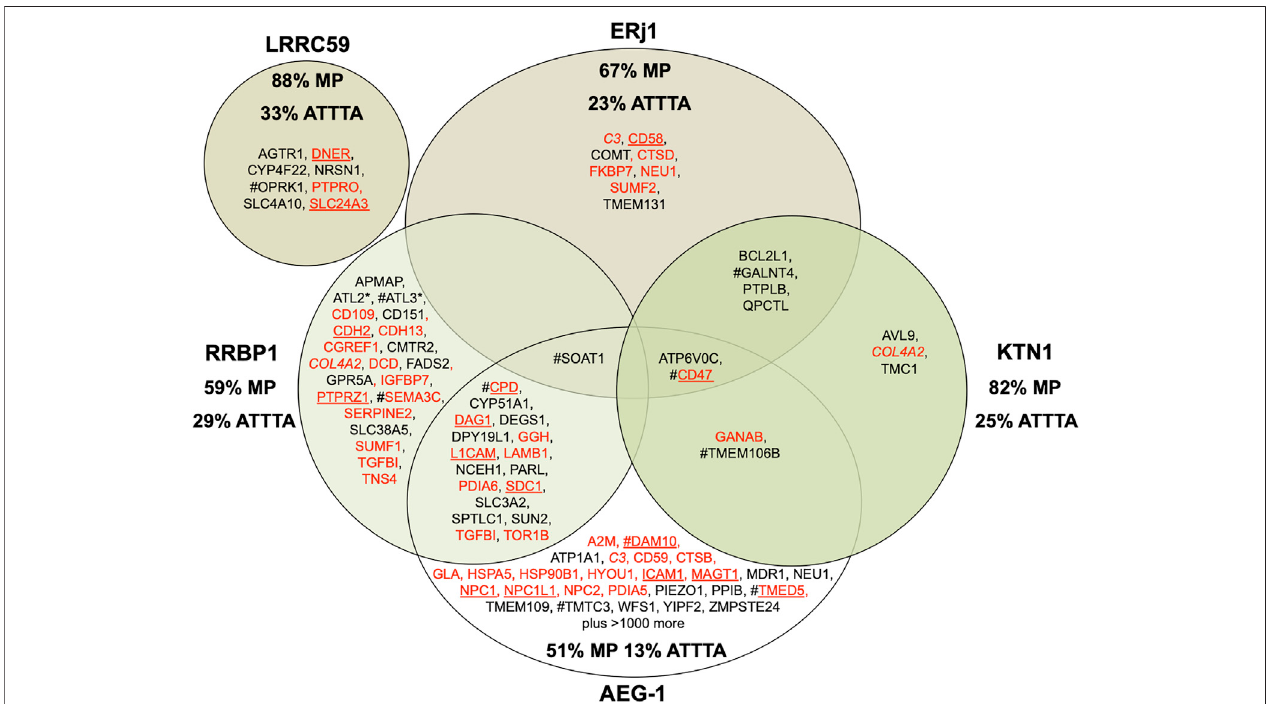
FIGURE 5 | Venn diagram for putative mRNA and RNC targeting components in the human ER membrane and their clients. The diagram summarizes precursors withSP (in red) or TMH(in black), which aredestined tothe secretorypathway and werenegativelyaffectedby theindicated depletion in HeLacells (Bhadra et al., 2021) orwereidenti fi edbymRNAcrosslinkingandribosomeproximitylabeling,respectively(Hsuetal.,2018;Hanniganetal.,2020);membraneproteinprecursorswithSPare underlined.Alltheseprecursorpolypeptidesarede fi nedaspotentialclientsorsubstratesoftherespectivecomponent.Thepercentageofmembraneproteins(MP) of the secretory pathway among the respective clients is indicated (%). For AEG-1 randomly selected examples of secretory pathway clients are shown and the % MP refers to the complete set of clients; for LRRC59 the secretory pathway representatives among the top twenty clients are shown and the % MP refers to these clients. COL4A2 is in italics to highlight that it was negatively affected by RRBP1 as well as KTN1 depletion. # highlights the presence of multiple ATTTA motifs in all mRNAs clients (i.e., ATTTA ≥ 10), which was tested for the top twenty clients in the case LRRC59 and for the complete set of clients in all other cases. Asterisks indicate hairpin